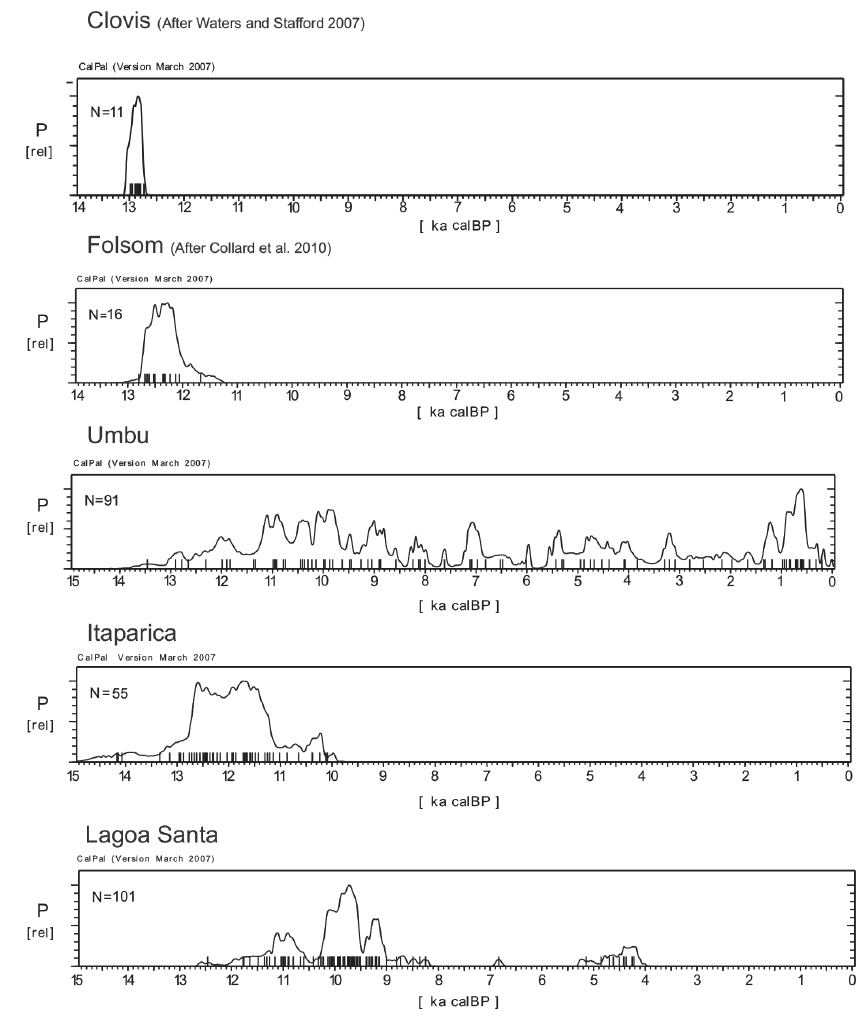
Figure 2 - Summed probability distributions of the radiocarbon ages for the Paleoindian traditions mentioned in the